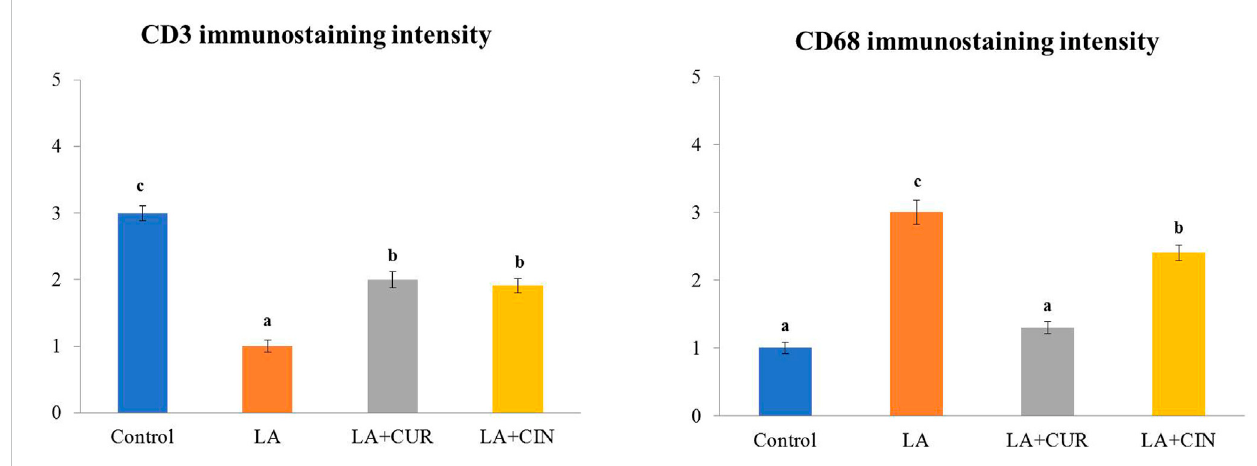
FIGURE 10 Immunohistochemical intensities of CD3 and CD68 in the spleen of all experimental